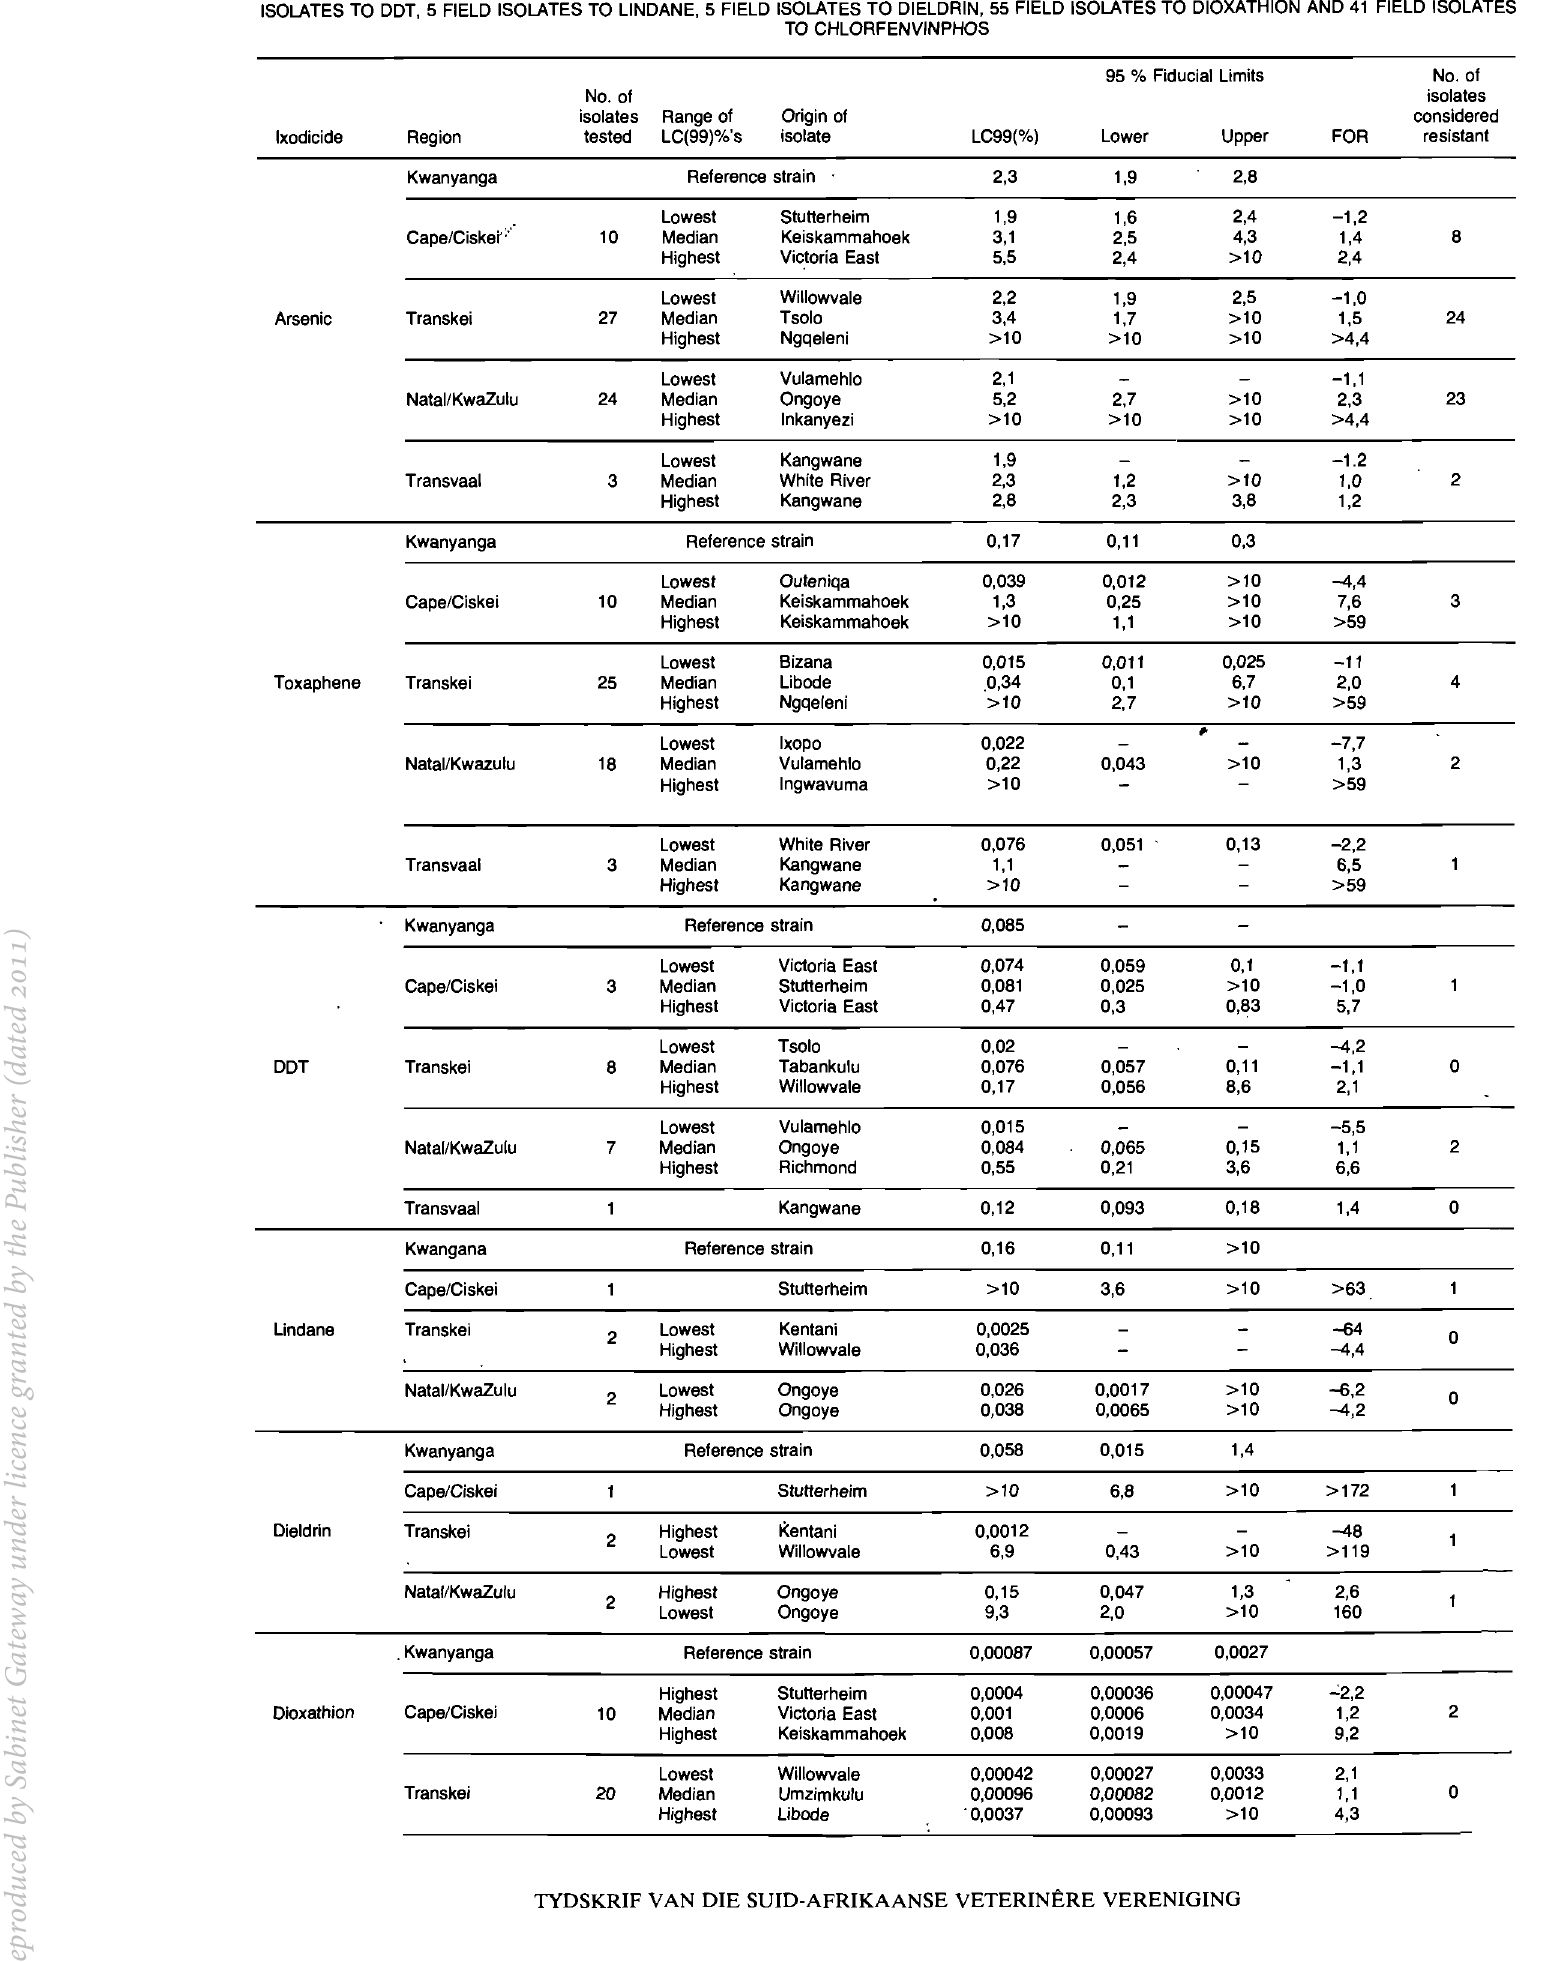
Table 1: THE SUSCEPTIBILITY OF 64 FIELD ISOLATES OF BOOPHILUS MICROPLUSTO ARSENIC, 56 FIELD ISOLATES TO TOXAPHENE, 19 FIELD ISOLATES TO DDT, 5 FIELD ISOLATES TO LINDANE, 5 FIELD ISOLATES TO DIELDRIN, 55 FIELD ISOLATES TO DIOXATHION AND 41 FIELD ISOLATES TO CHLORFENVINPHOS 95 % Fiducial Limits No. of No.